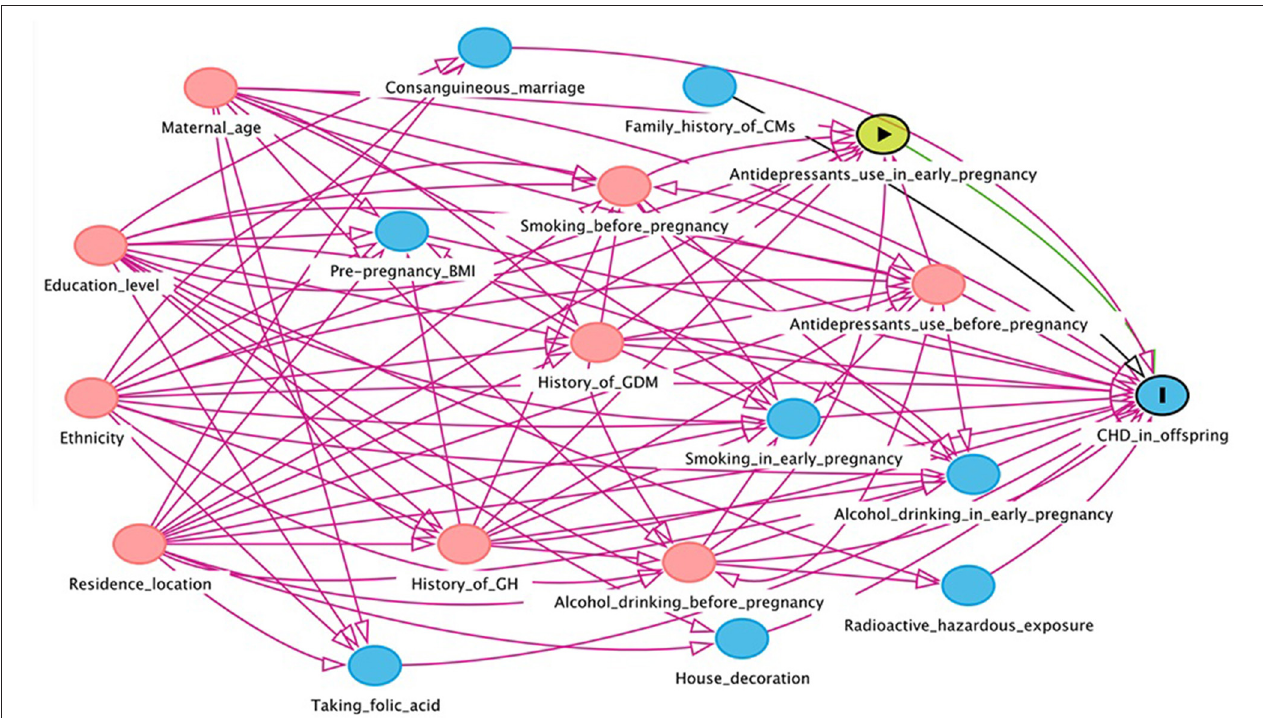
FIGURE 2 | Directed acyclic graph for the association between maternal antidepressant use in early pregnancy and risk of CHD in offspring. Red arrows indicate biasing paths, green arrows indicate causal paths. Minimal sufficient adjustment sets for estimating the effect of maternal antidepressant use in early pregnancy on offspring CHD: maternal age, ethnicity, residence location, education level, history of gestational diabetes mellitus, history of gestational hypertension, smoking before pregnancy, alcohol drinking before pregnancy and antidepressants use before pregnancy. BMI, body mass index; CHD, congenital heart disease; CM, congenital malformation; GDM, gestational diabetes mellitus; GH, gestational